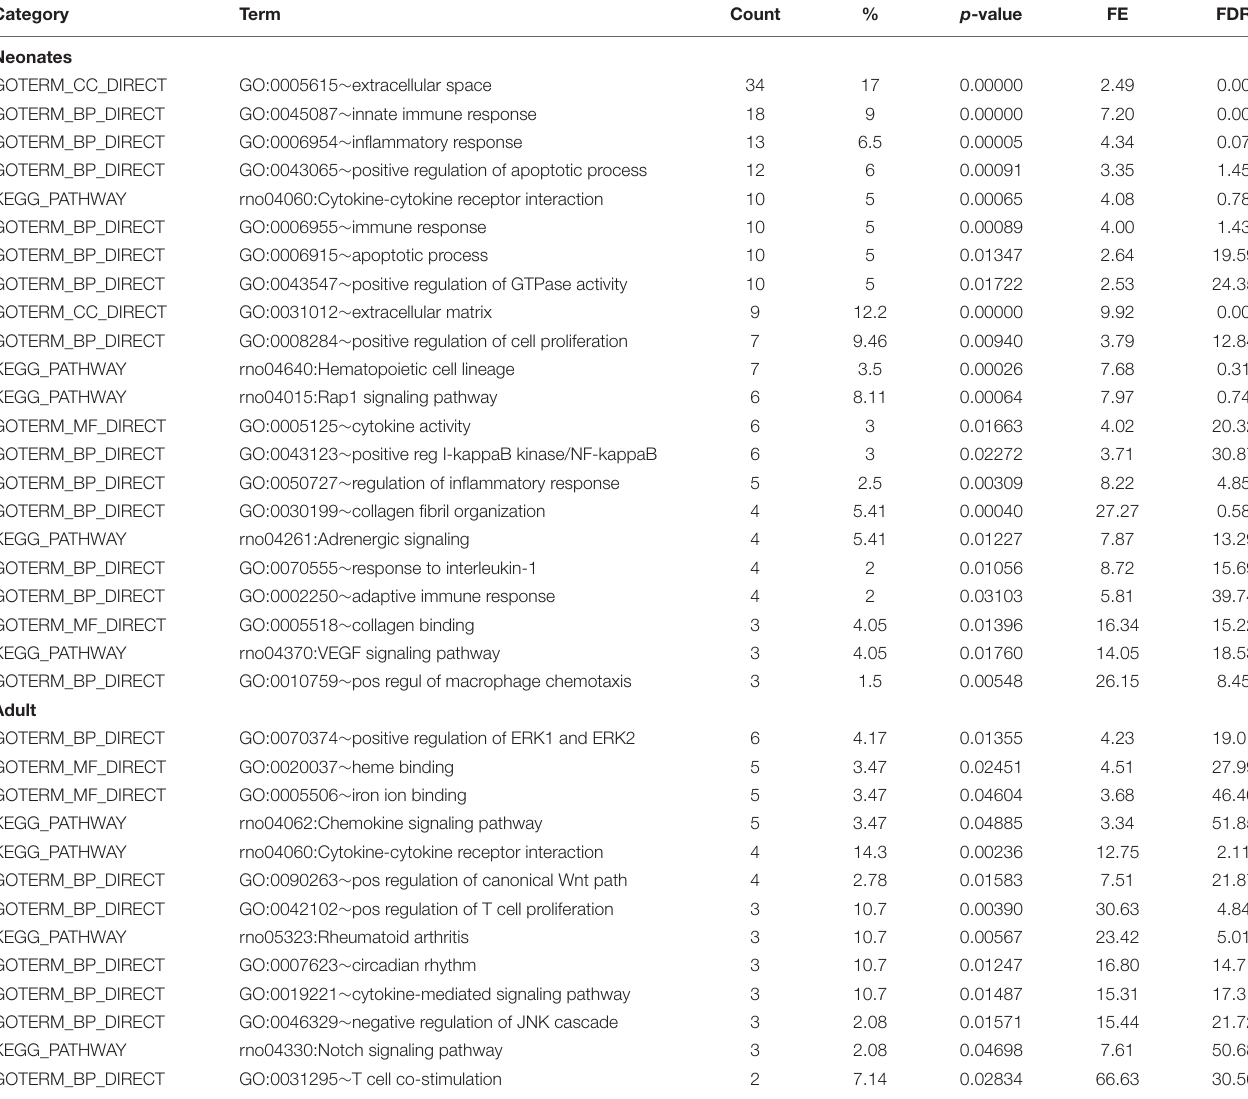
TABLE 4 | Enriched Biological Pathways functional clusters (EBPfc) affected by